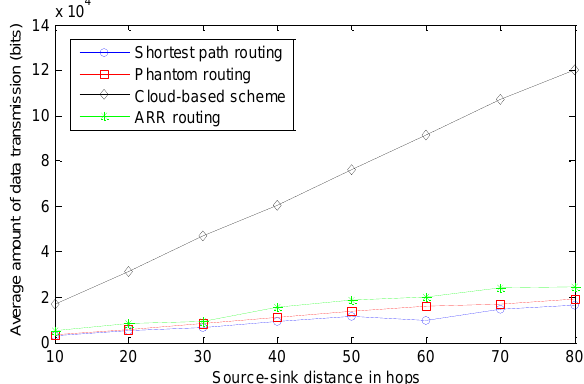
Figure 14. Average amount of data transmission per round.